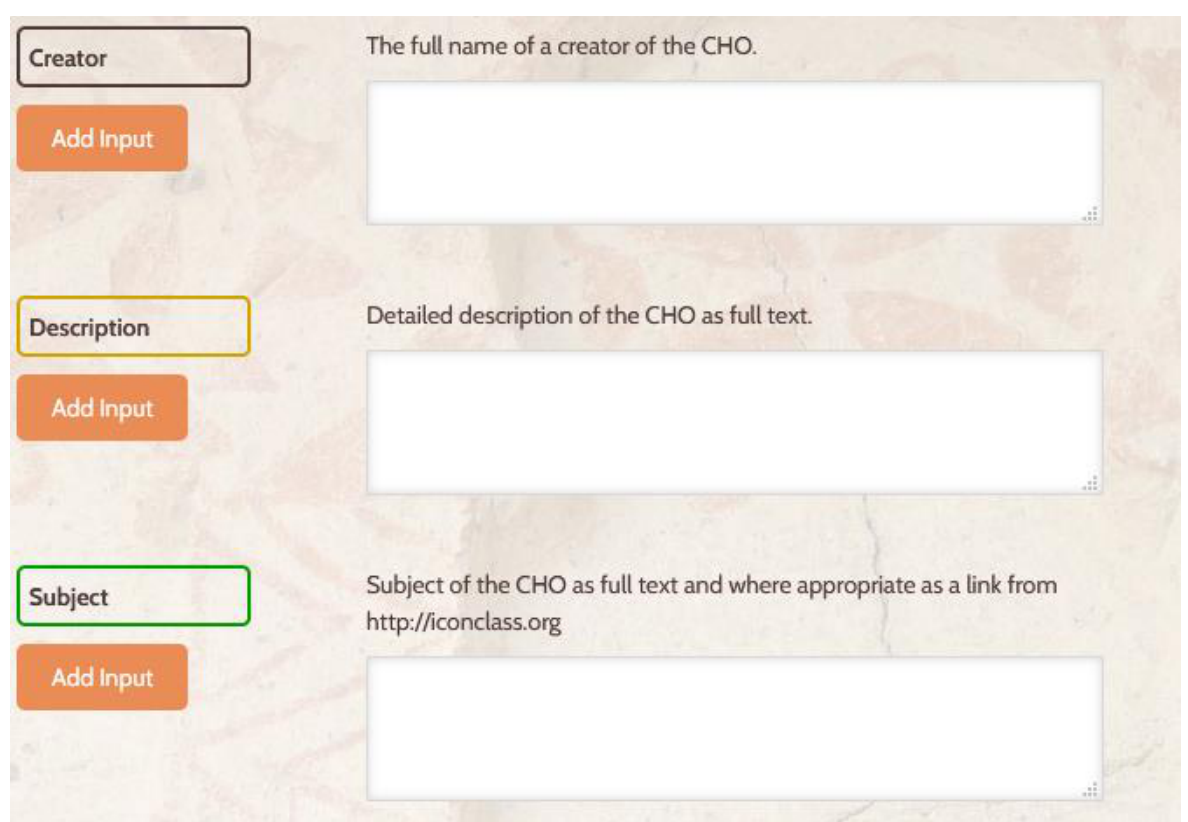
Figure 3. Color coding in the Omeka item-adding form.